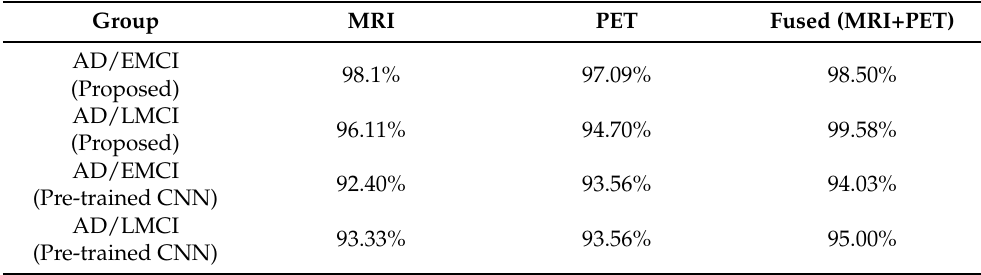
Table 2. Training precision of the proposed model and pre-trained CNN using PET, MRI, and fused data (MRI +